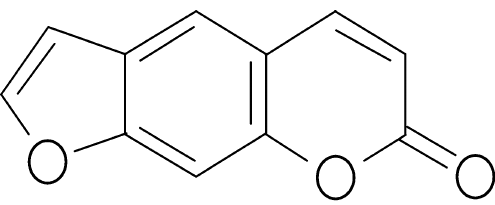
Figure 1. Molecular structure of fructus psoraleae’s extract